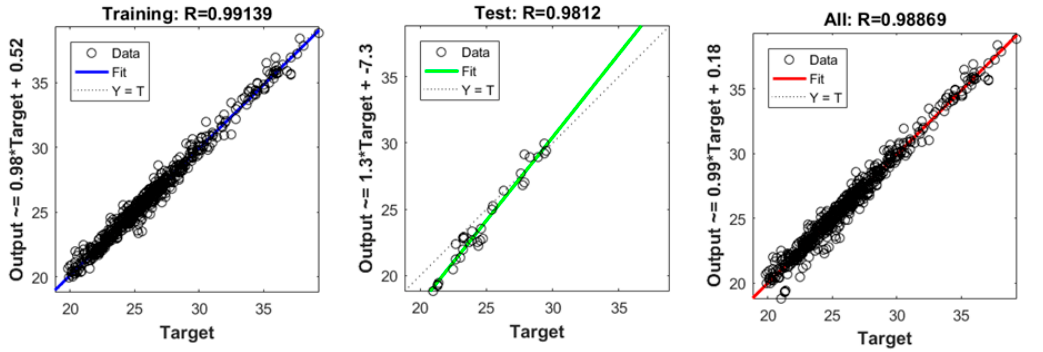
Figure 20. ANN regression plot.